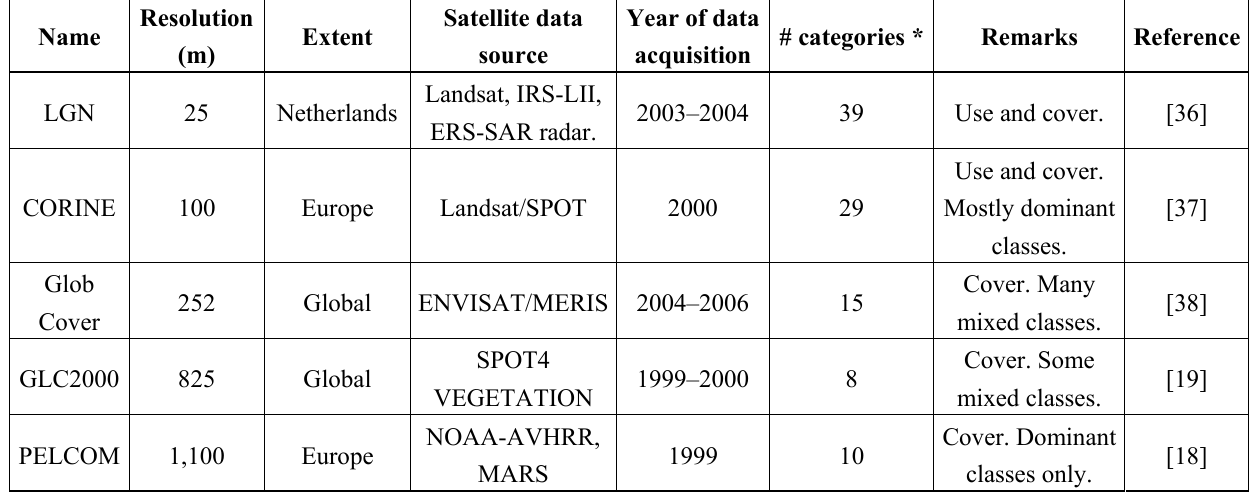
Table 1. Characteristics of the land cover